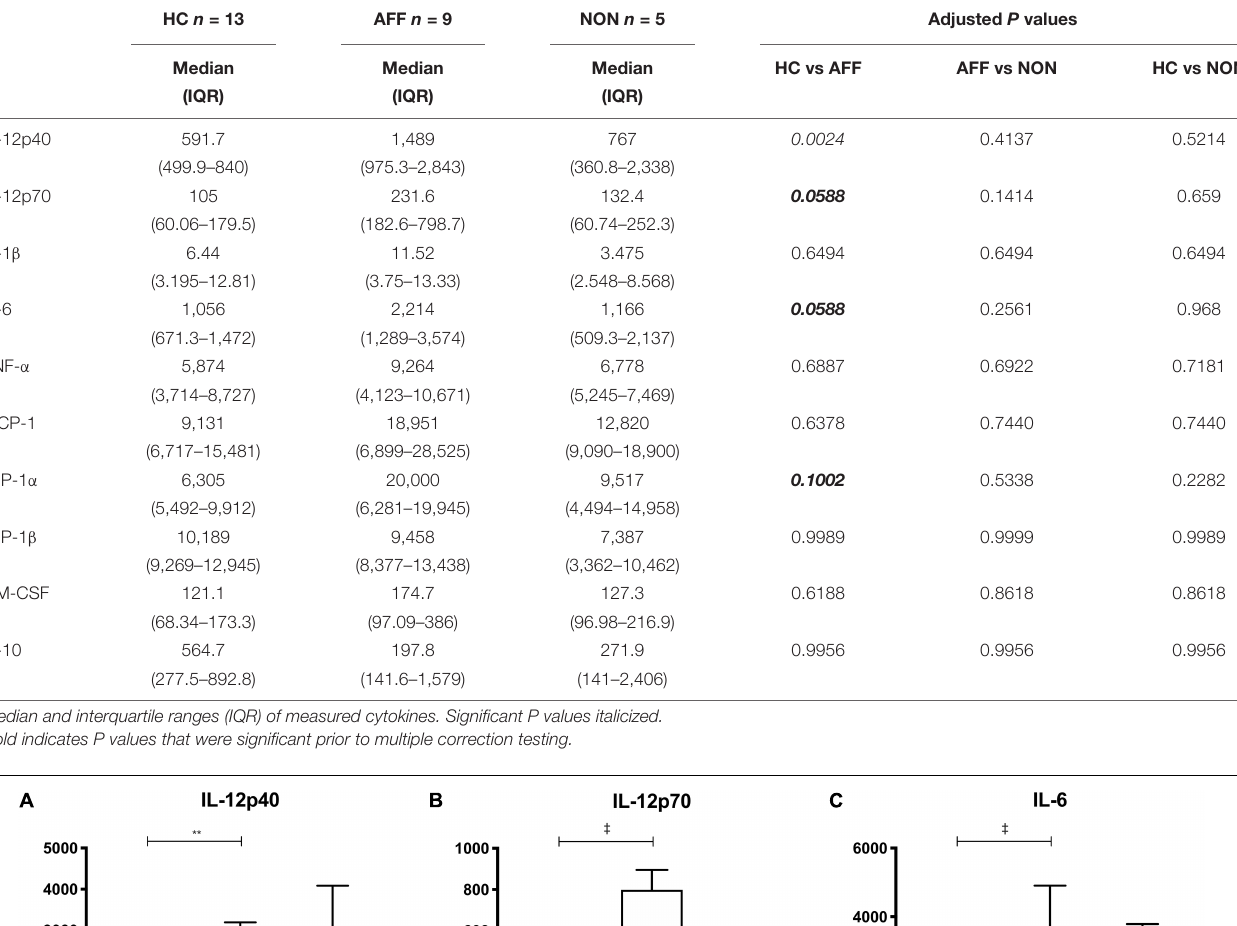
TABLE 5 | Concentration of cytokines/chemokines after LPS + IL-4 stimulation.